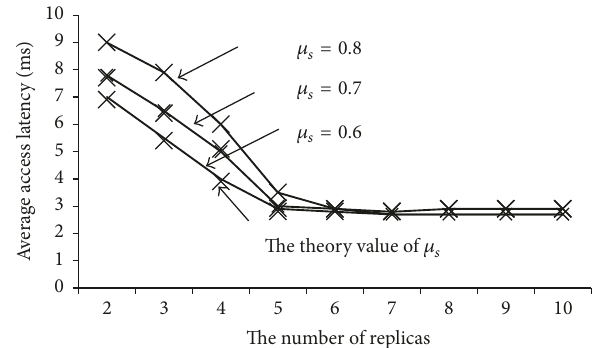
Figure 4: Benefit function with number 𝐼 of replicas.